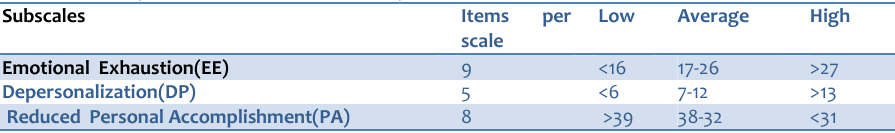
Table 1: Norms of the Maslach Burnout Inventory